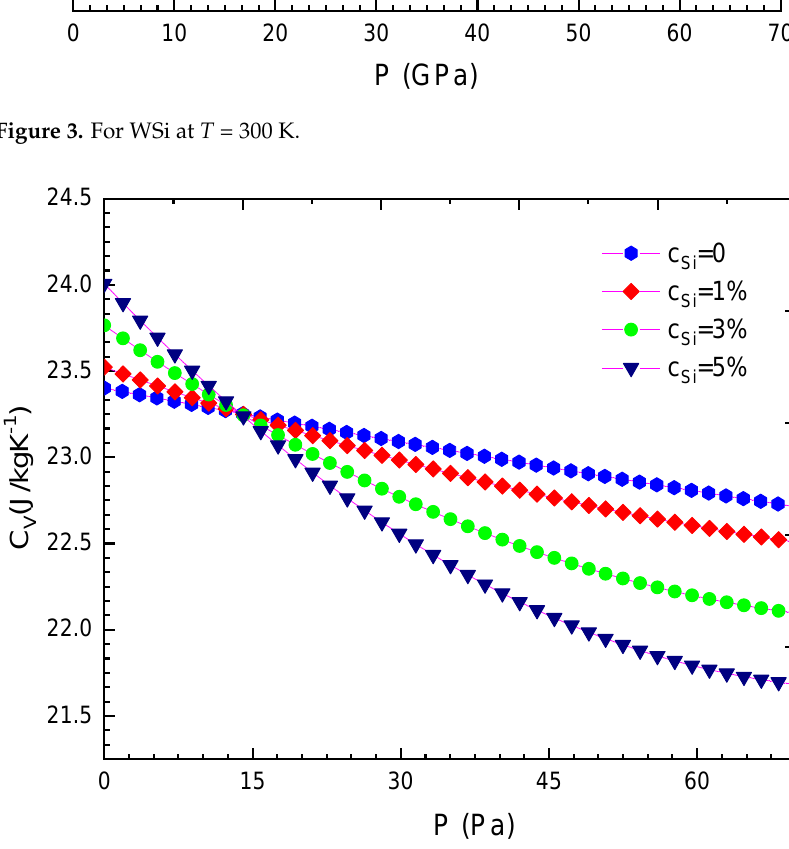
Figure 4. For WSi at T = 300 K. Table 5. Si concentration and pressure dependence of specific capacity at constant volume for WSi at T = 300 K.